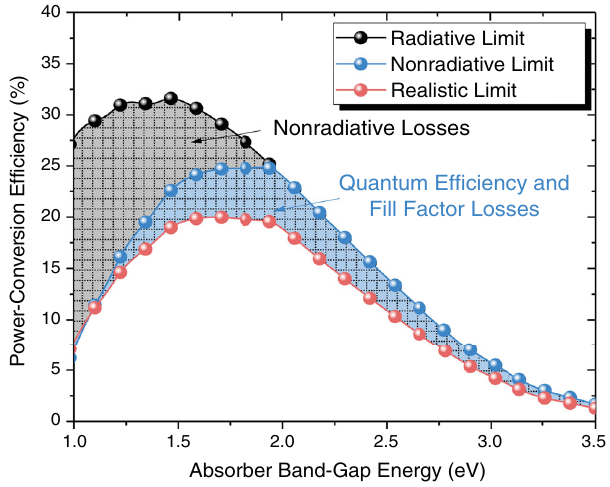
FIG. 5. Predicted power-conversion efficiency compared with the radiative limit. The black line is the SQ limit using the AM1.5G sun spectrum, where only radiative recombination is considered; the blue line is the nonradiative limit considering a perfect charge collection (100% of the EQE calculated from modeled absorption spectra) and the ideal Shockley equation (ideality factor of 1); the red line is the more realistic limit assuming 90% EQE absorption and 80% fill